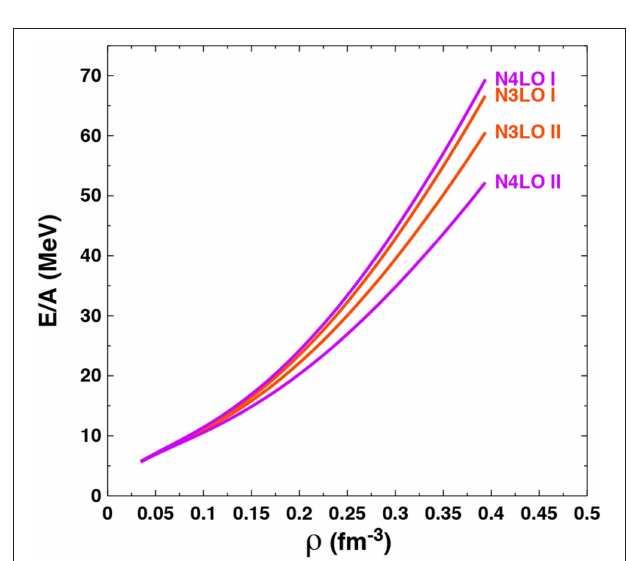
from Drischler et al. [93]. There, chiral interactions including